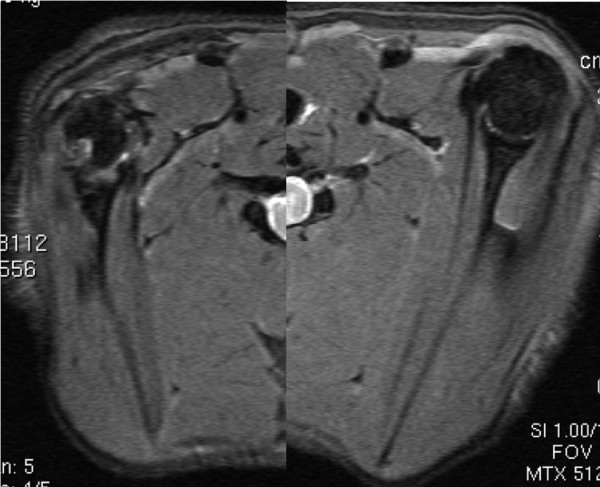
Shoulder MRI 16 weeks after surgery showing a loss of relationship between the glenoid -which presents a normal version- and a marked deformed humeral head. An advanced right glenohumeral joint hypoplasia is present. The distinctive shoulder dysplasia found in humans is absent.